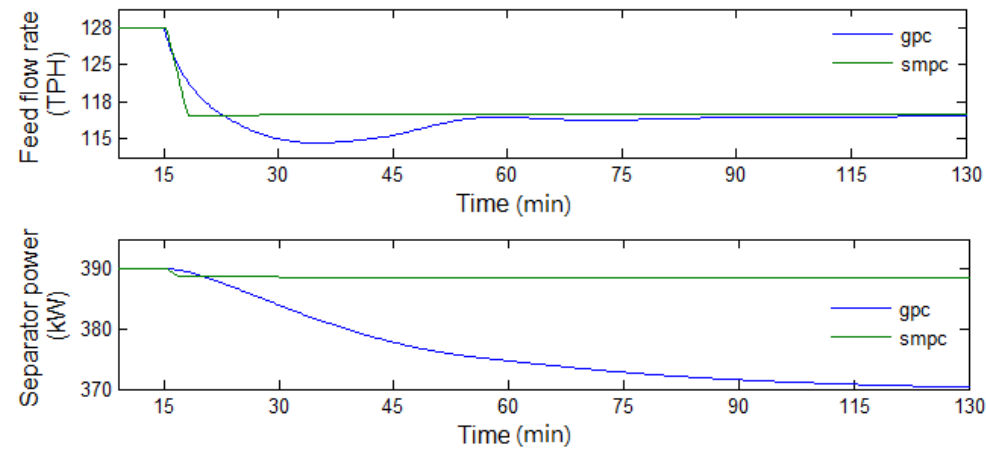
Figure 4. ( a ) Variations in the process and ( b ) manipulating variables—namely, the main drive load, elevator current, feed flow rate, and separator power—on introducing different controllers viz. Generalized Predictive Controller (GPC) and State Space Model Predictive Controller (SSMPC).